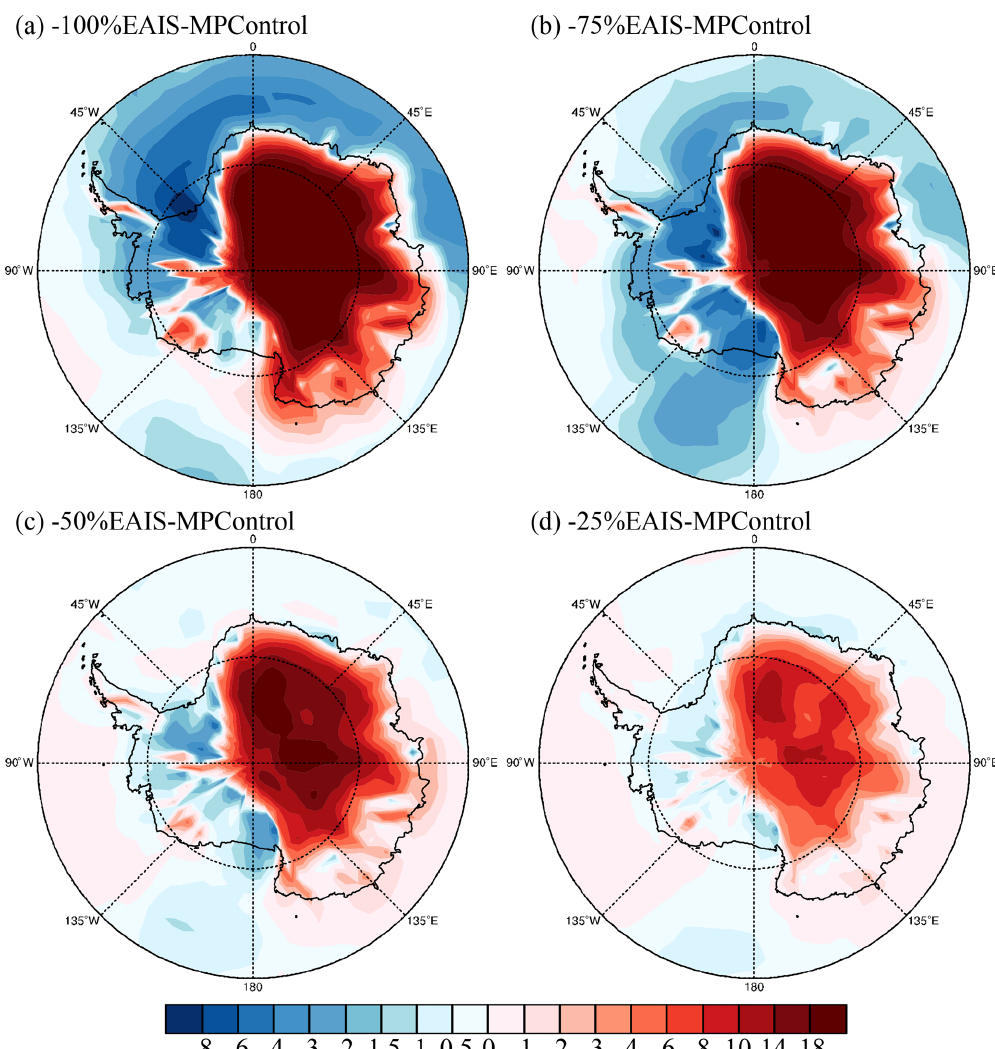
Figure 2. Spatial distribution of the annual mean surface temperature anomalies (units: ◦ C) over Antarctica between sensitivity experiments and MPControl